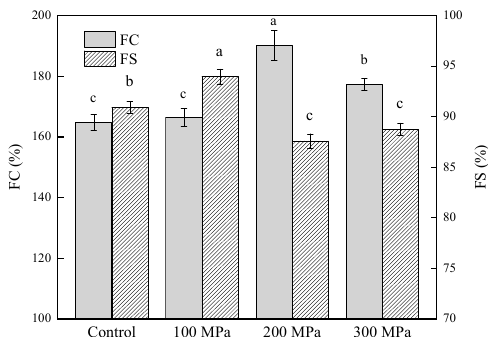
Figure 3. Effect of HHP pretreatment on the FC and FS of RBPH. HHP: high hydrostatic pressure; RBPH: rice bran protein hydrolysates; FC: foaming capacity; FS: foaming stability. Control, 100 MPa, 200 MPa, and 300 MPa represent RBPH samples subjected to 0, 100, 200, and 300 MPa pretreatment, respectively. Different lowercase letters indicate values that differ significantly ( p < 0.05). All the HHP pretreatments were conducted at 25 °C for 30 min.